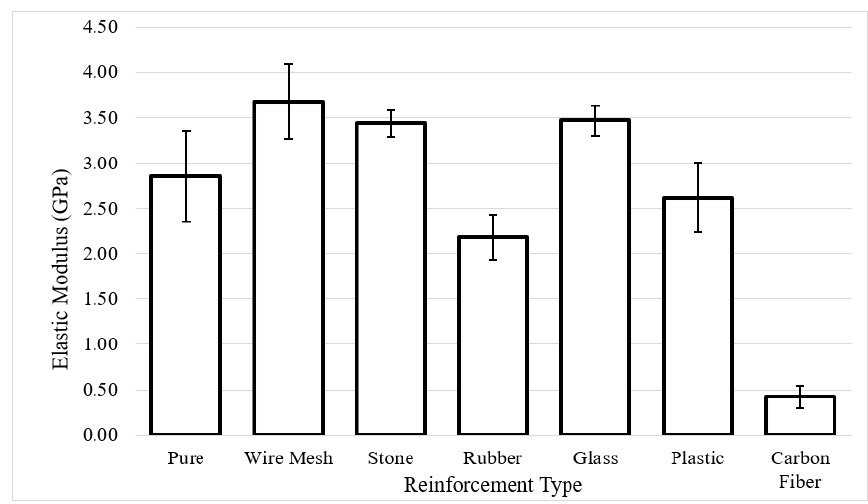
Figure 6. Average Elastic Modulus for Each Reinforcement Type.